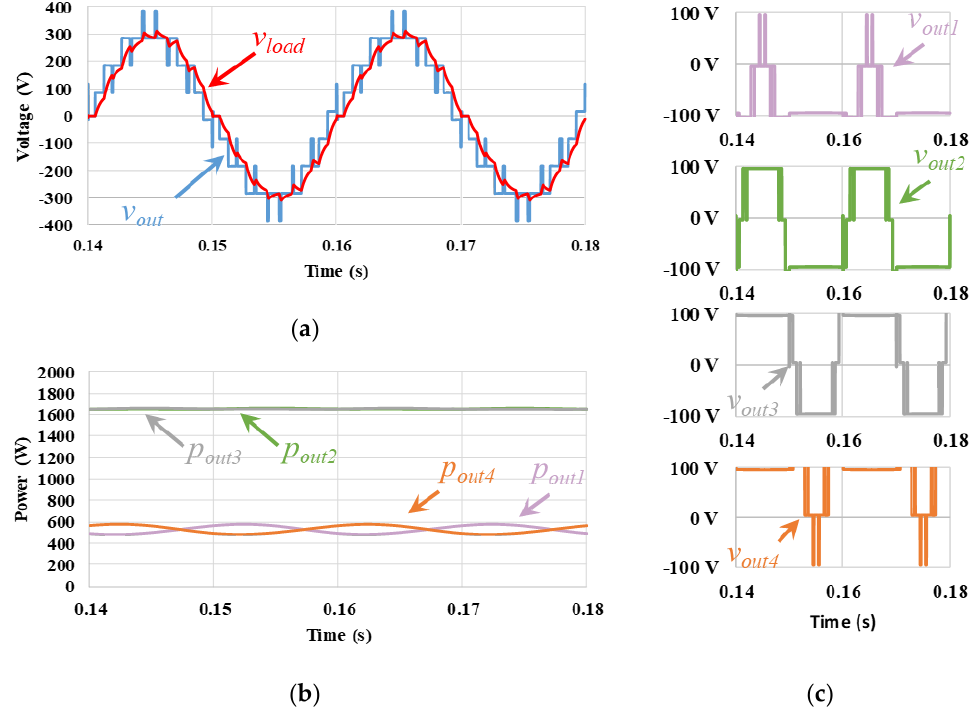
Figure 15. Simulation results of the APOD PWM technique: ( a ) output voltage of the cascaded MLC, v out , and load voltage, v load ; ( b ) output power on each submodule ( p out1 , p out2 , p out3 , p out4 ); ( c ) output voltage on each submodule ( v out1 , v out2 , v out3 , v out4 ).